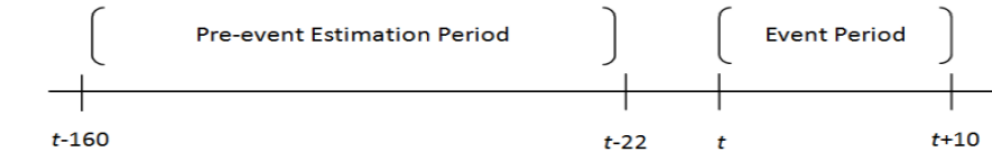
Figure 2. Time vector of event window (event period and estimation